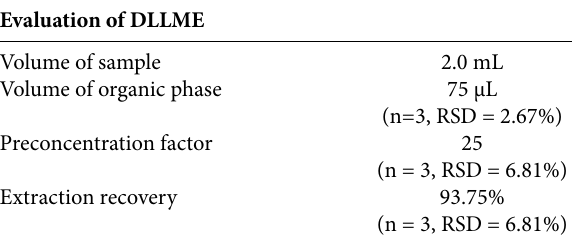
Table 2. Evaluation of optimized DLLME method with model urine sample spiked with estradiol (0.1 mg mL –1 )